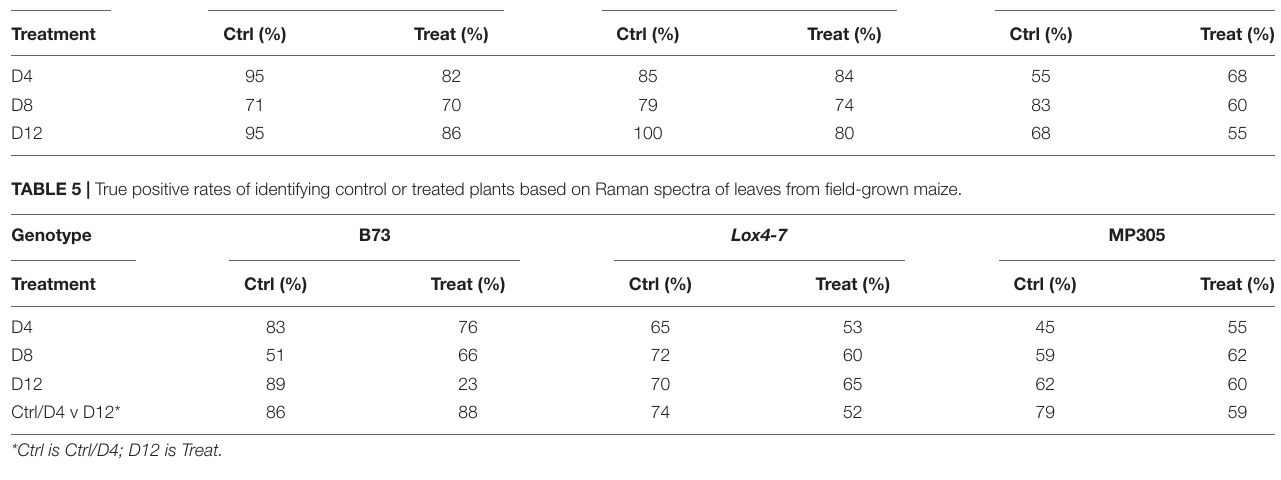
TABLE 4 | True positive rates of identifying control and treated plants based on Raman spectra of leaves from greenhouse-grown maize. Genotype Treatment